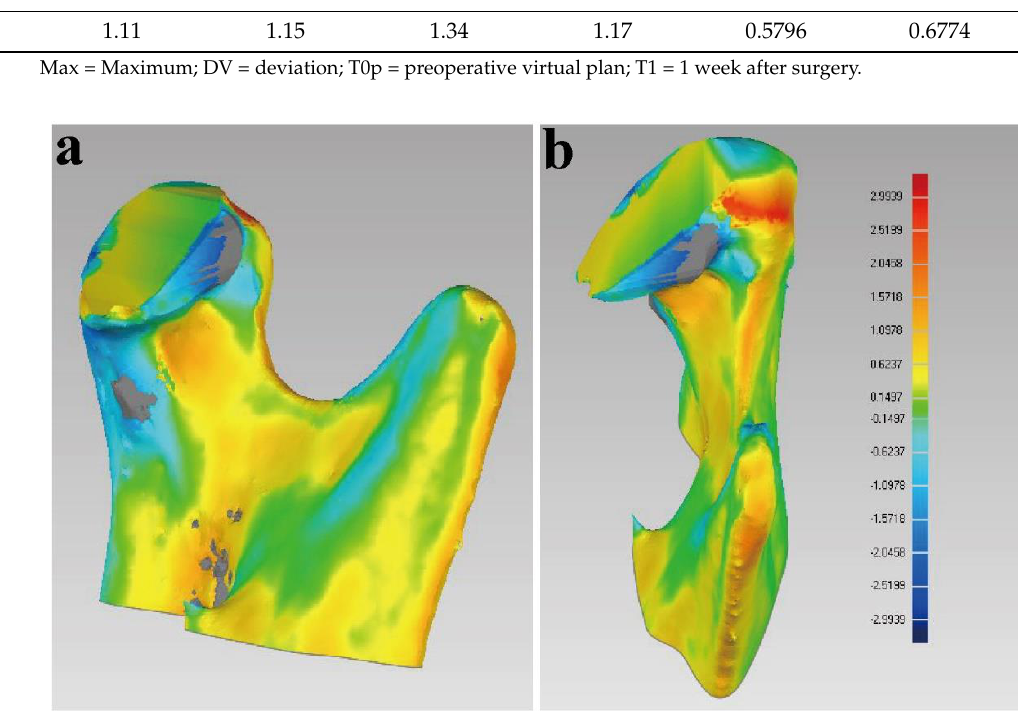
liner measurements, the distance of the Go to FH on the OC-affected side, and the B, Pog, and Pog* points to the SP plane on the non-OC affected side, were statistically significantly reduced ( p < 0.05). The deviation angles of the B and Pog* points to the SP plane were also decreased postoperatively ( p < 0.05). These results showed that facial deformity was corrected in both the bone and the soft